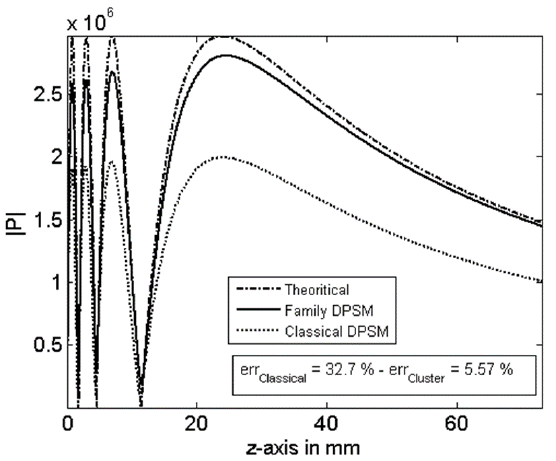
Figure 9. Pressure variation along the central axis in front of the transducer: dashed-dotted line—theoretical value; solid line—computed results using source clusters, as shown in Figure 3; and dashed line—computed by superimposing individual point source contributions, as shown in Figure 1.